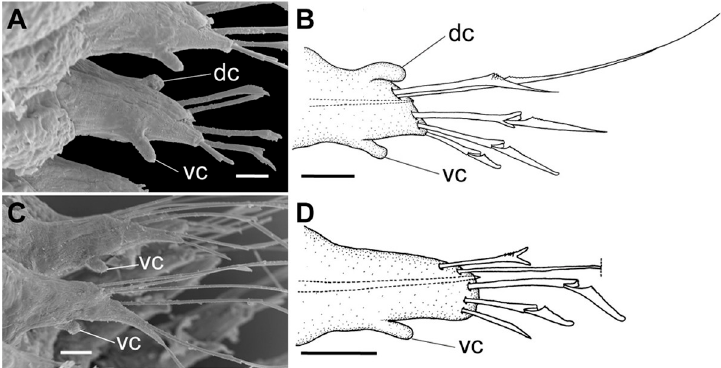
Fig 20. Meiodorvillea jumarsi sp. nov. (A,B) parapodia from anterior region; (C,D) parapodia from posterior region; all anterior view. Abbreviations: dc = dorsal cirrus; vc = ventral cirrus. Scale bars: (A,C) = 10 μ m; (B,D) = 15.6 μ